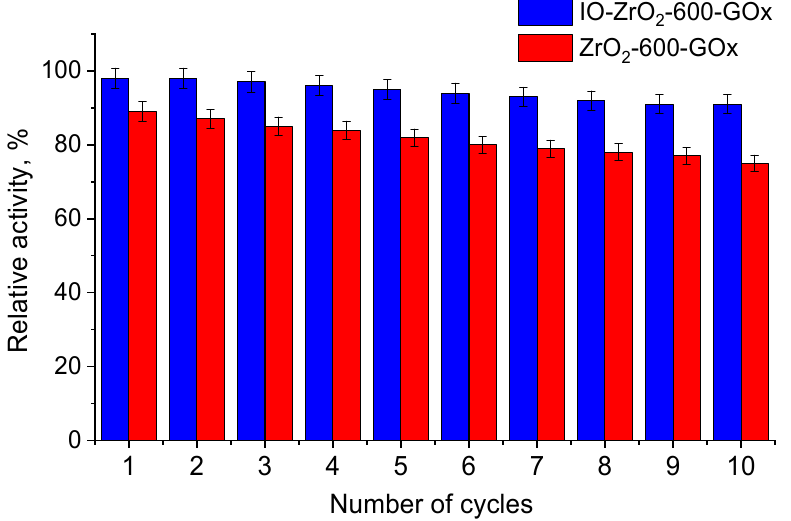
Figure 3. Relative activity of GOx immobilized on ZrO 2 or Fe 3 O 4 -ZrO 2 in reuse. IO stands for Fe 3 O 4 NPs, while 600 indicates the temperature at which ZrO 2 was treated. Reproduced with permission from [41], the American Chemical Society, 2020.